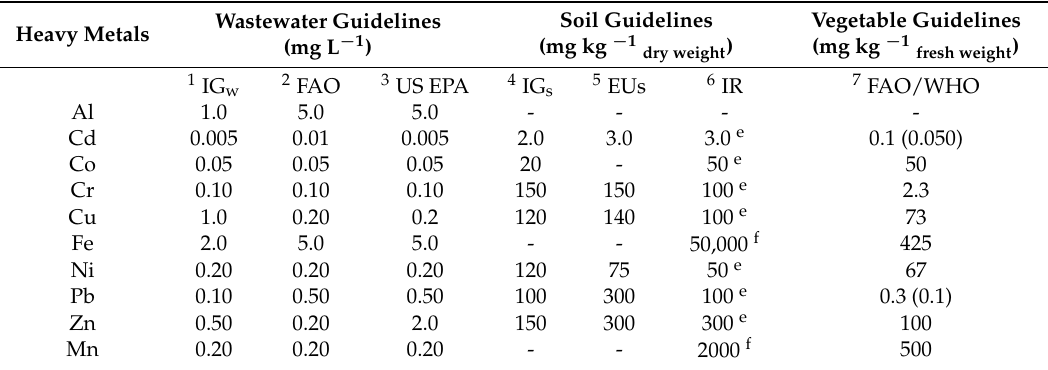
Table 1. National and international guidelines for maximum limits of heavy metals in irrigation water, soil and cultivated vegetables.